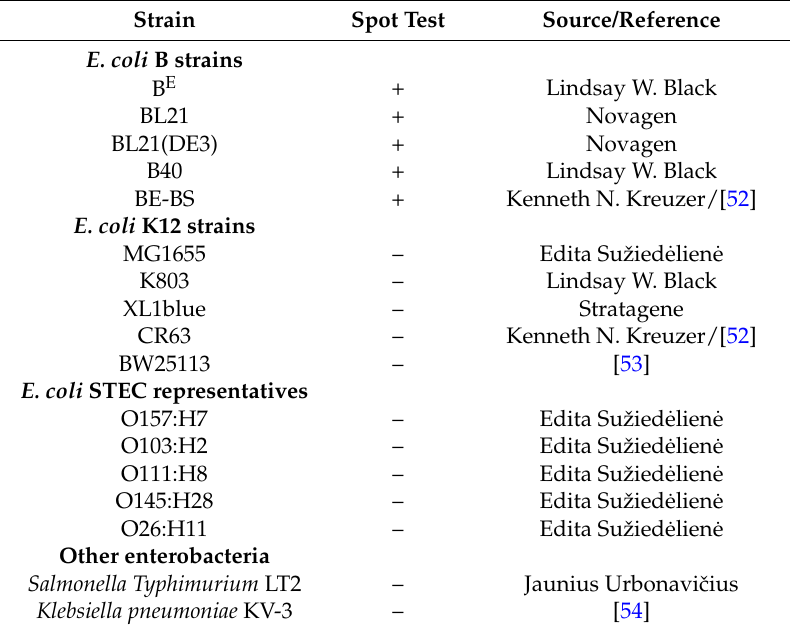
Table 1. Host Range of